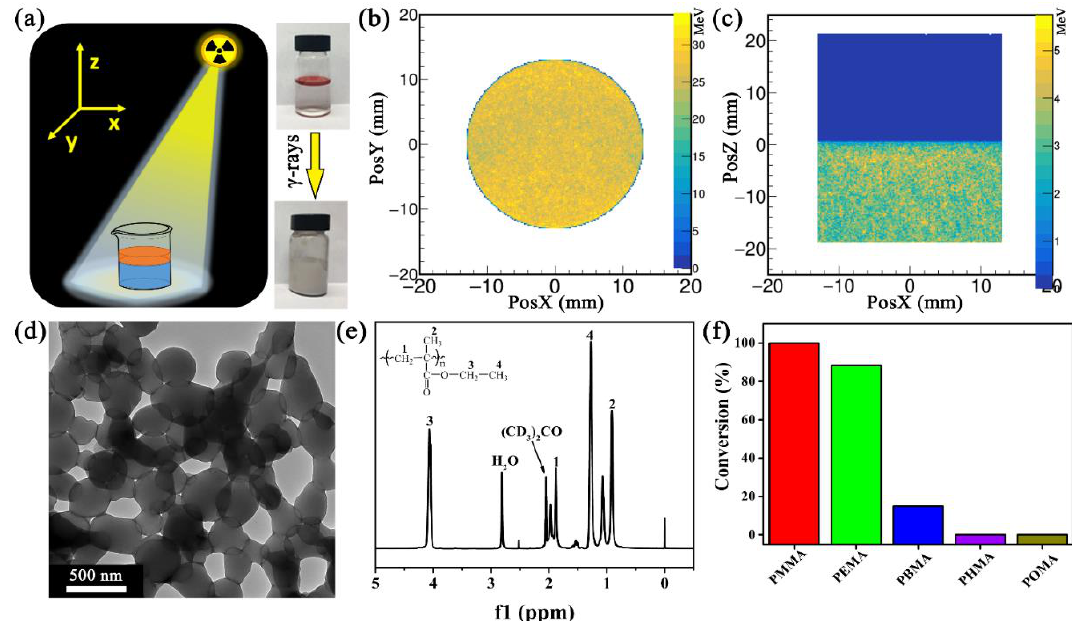
Figure 1. ( a ) Schematic illustration of the experiment setup and the photographs of EMA–H2O mixture (0.5 / 10 v / v ) before and after γ -ray-induced LLISA polymerization. EMA is dyed by oil red for visualization; GEANT4 (geometry and tracking 4) stimulation of energy deposition on EMA–H 2 O mixture under γ -rays at ( b ) x–y and ( c ) x–z (y = 0) direction; ( d ) TEM and ( e ) 1 H NMR of PEMA assembly; ( f ) Conversion of different polymers synthesized via γ -ray-induced LLISA polymerization. EMA: ethyl methacrylate.